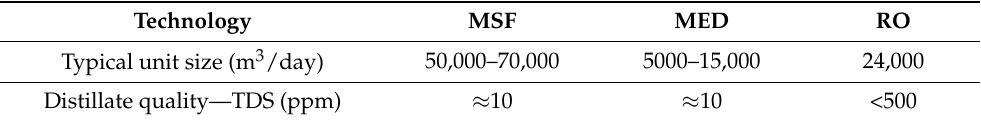
Table 2. Key differences between the main desalination technologies (MSF, MED and RO) in terms of unit capacity and distillate salinity. TDS: Total Dissolved Salt; ppm: part per million. Technology MSF MED RO Typical unit size (m 3 /day)